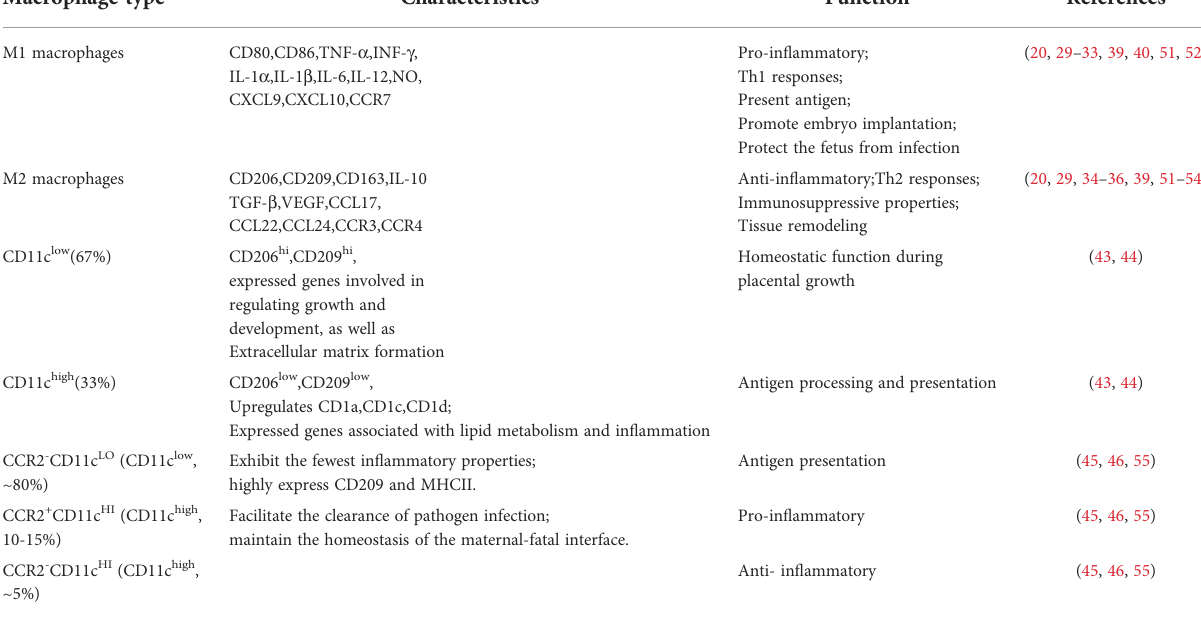
TABLE 1 Different phenotypes of macrophages during